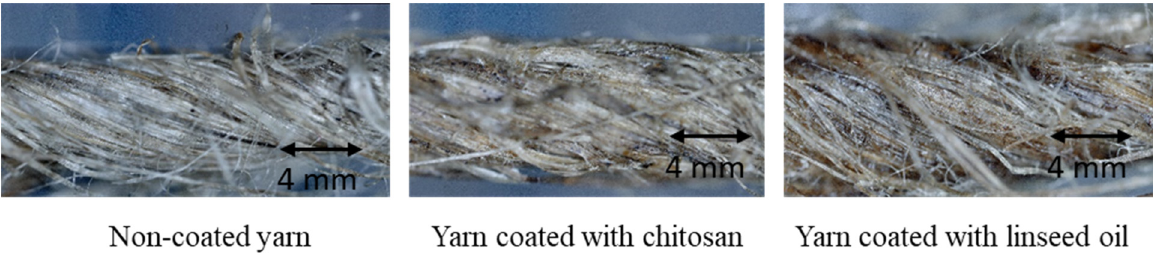
Figure 5. Microscopic representation of a non-coated yarn and yarns coated with chitosan or linseed oil.